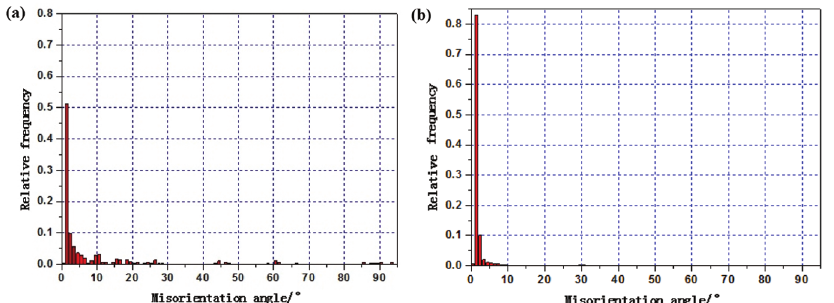
Figure 3: Distribution of grain boundary misorientation angles (the initial micro- structure): (a) α phase; (b)